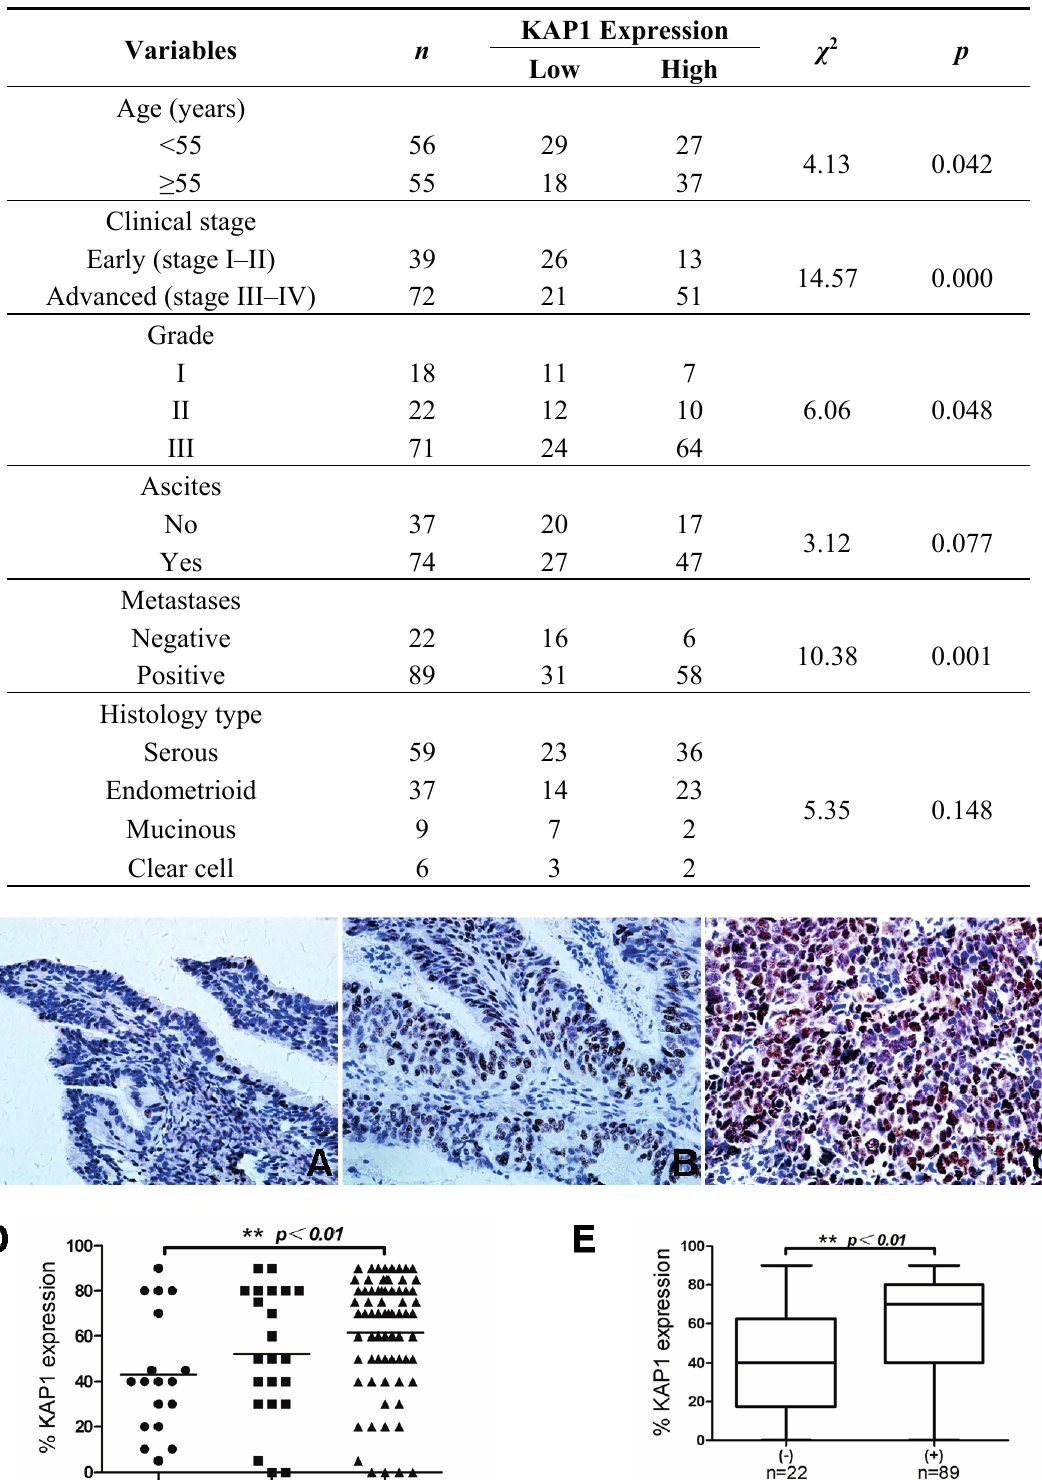
Table 2. Correlation between KAP1 expression and clinicopathological features in 111 patients with epithelial ovarian cancer.